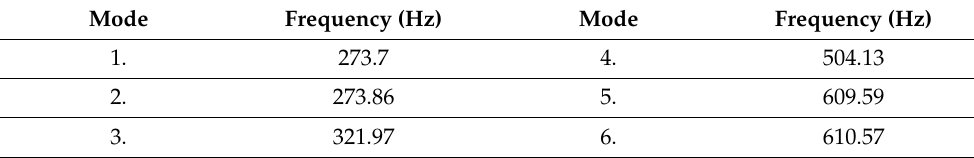
Table 4. The first six natural frequencies.